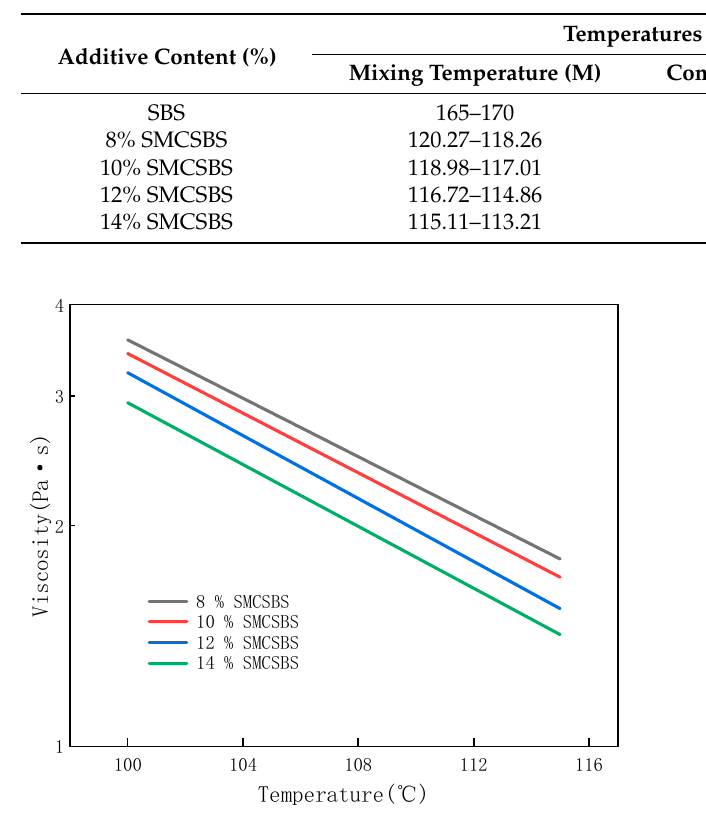
Figure 1. Viscosity-temperature curve of SMC normal temperature-modified asphalt and SBS- modified asphalt (SMCSBS) with different content.